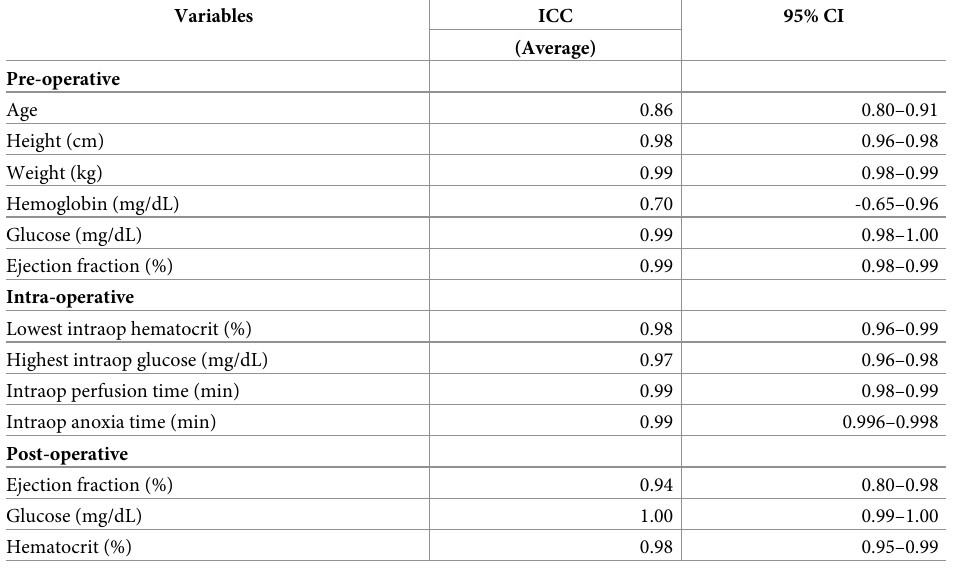
Table 3. Direct audit: ICC of numerical variables with, two-way random effects model. REPLICCAR II, 2019.